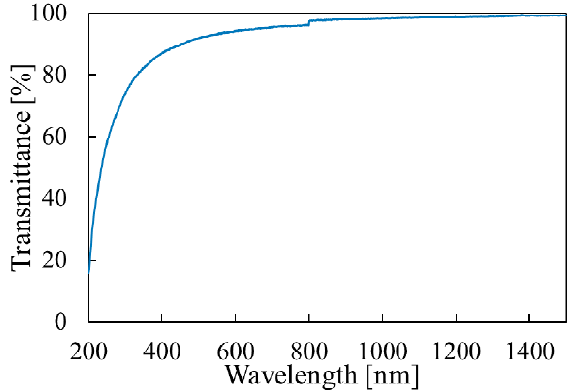
Figure 4. Optical transmittance measurement results of the Mg(OH) 2 film.